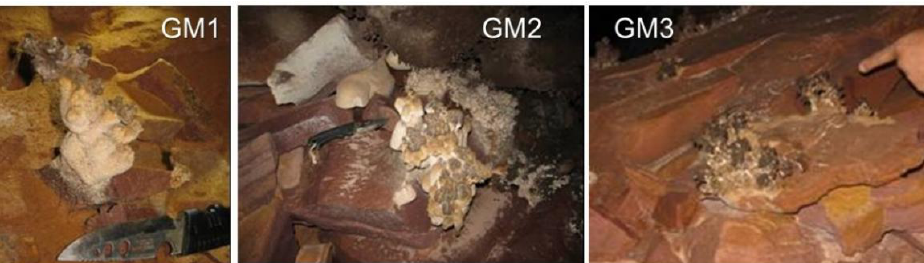
Figure 1. Site of sample collection in Cueva Charles Brewer (Charles Brewer Cave), Churi tepui. The cave map was modified from [9,12].